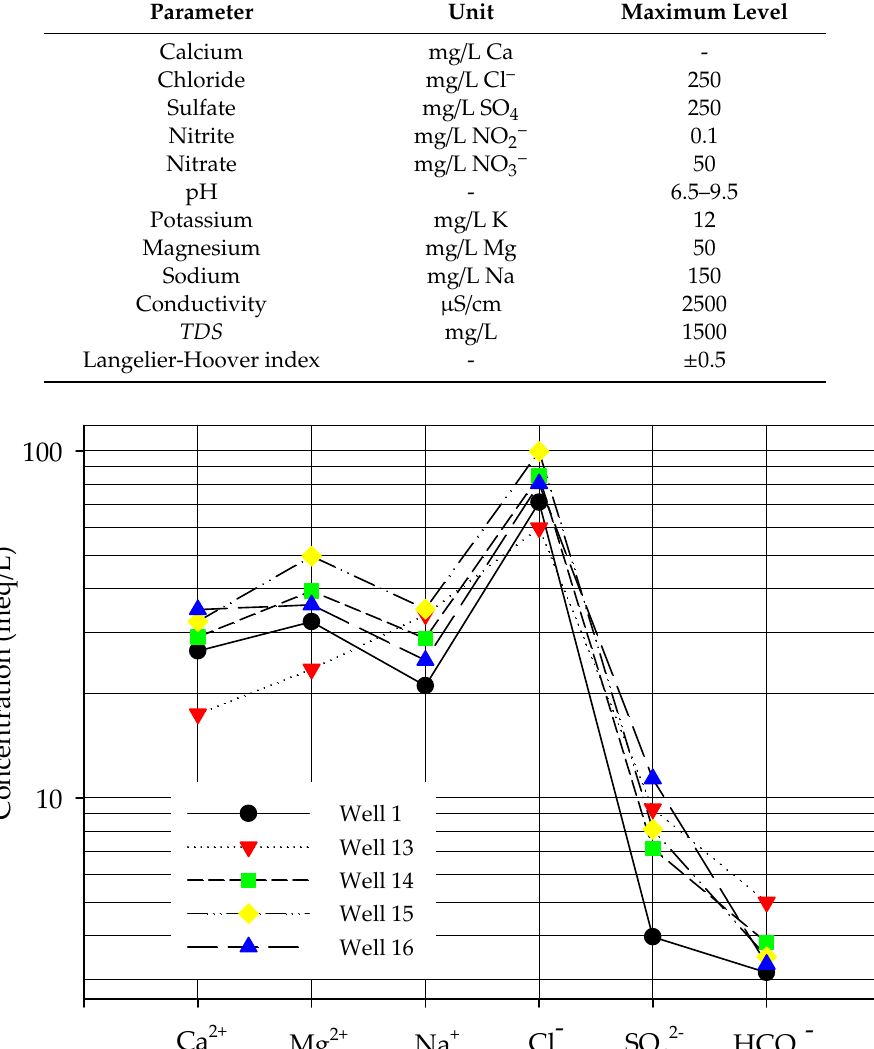
Table 6. Maximum admissible levels of concentrations of the various parameters tested in a drinkable water in accordance with [44].